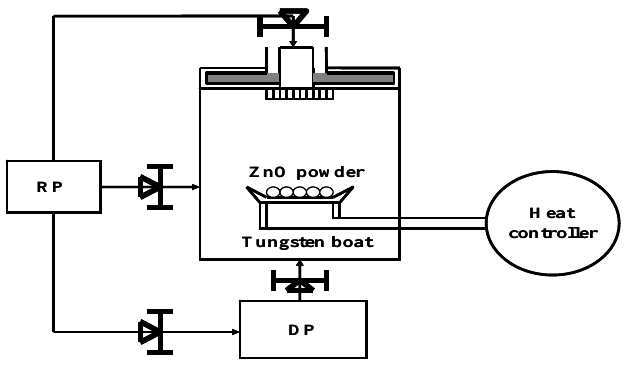
Figure 5. Setup of vapor cooling evaporation